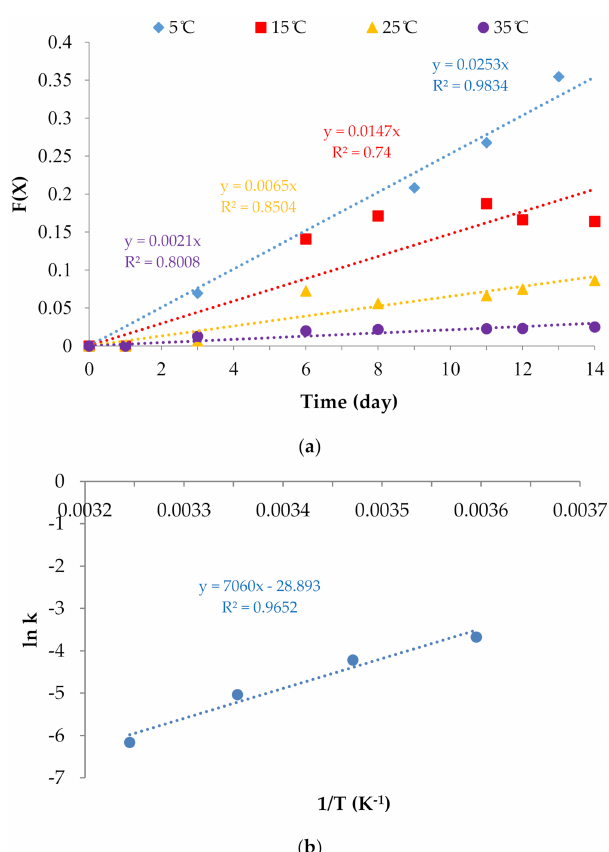
Figure 9. ( a ) A plot of the response function F(X) with time showed second-order kinetics at four di ff erent temperatures. ( b ) An Arrhenius plot of the response function F(X) for the total color di ff erence showed second-order kinetics at four di ff erent